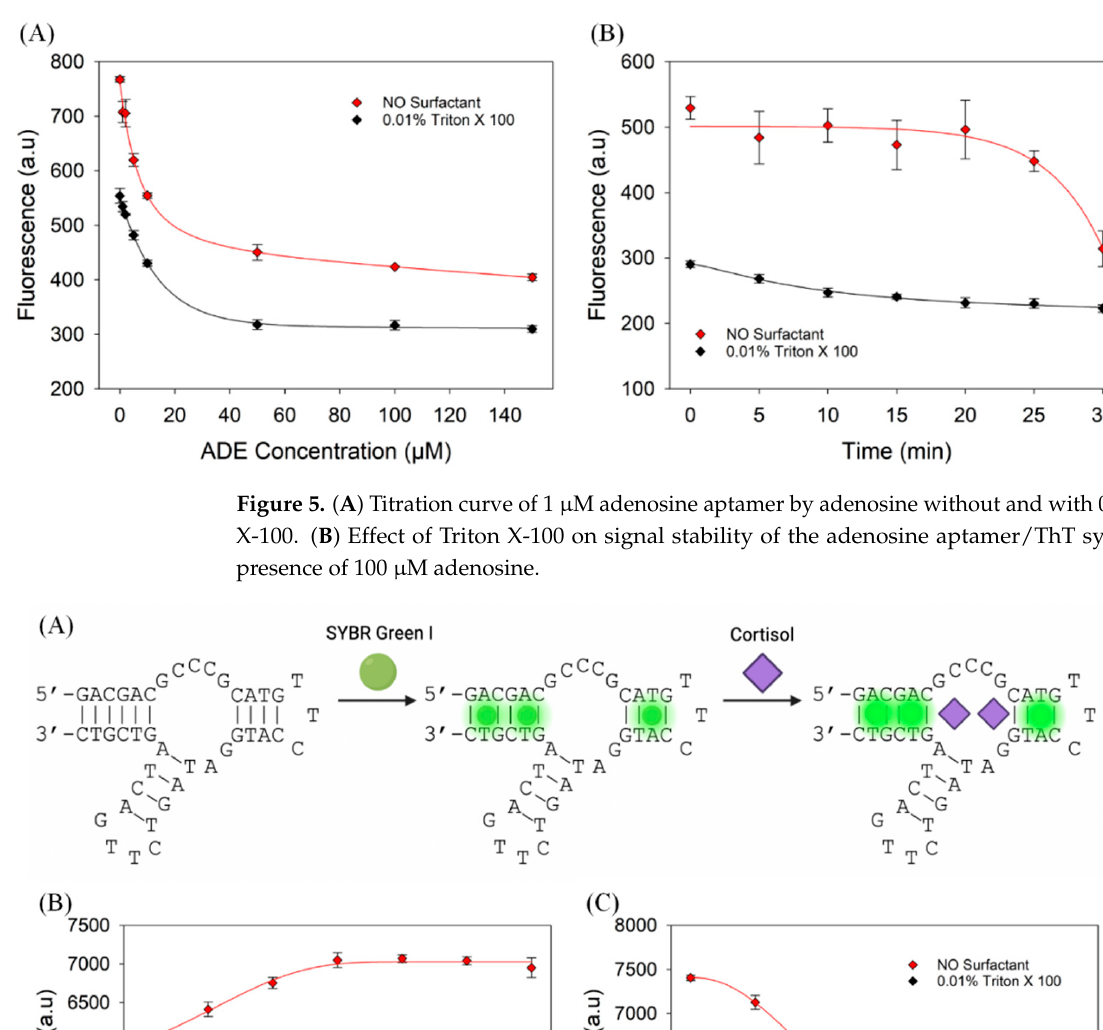
Figure 5. ( A ) Titration curve of 1 μ M adenosine aptamer by adenosine without and with 0.01% Tri- ton X-100. ( B ) Effect of Triton X-100 on signal stability of the adenosine aptamer/ThT system in the presence of 100 μ M adenosine.